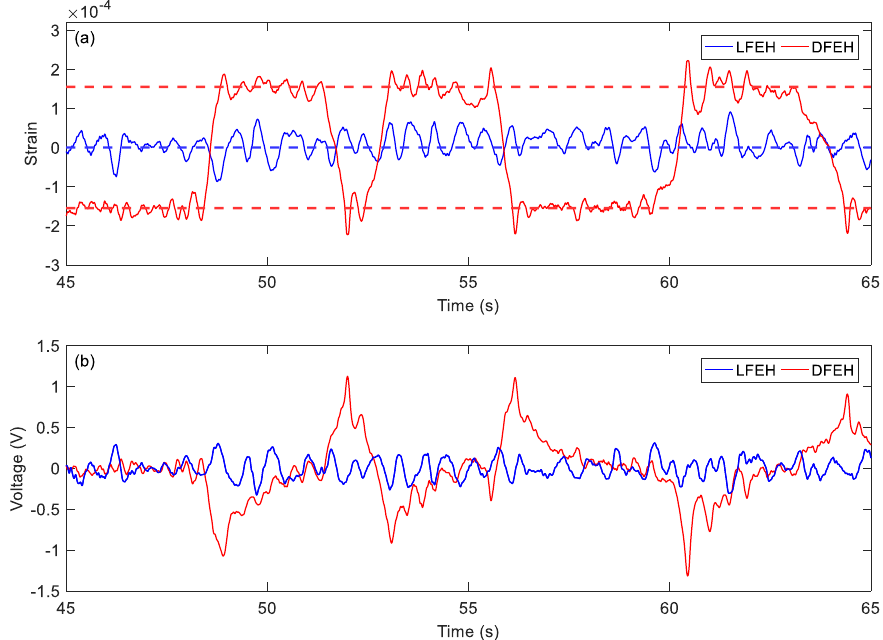
Figure 21. Bi-stable jumping ( a ) strain response and ( b ) voltage response ( 𝑣 = 2.5 m/s).